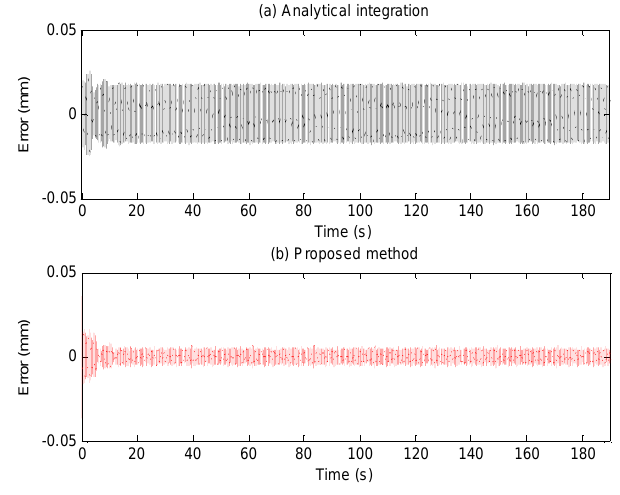
Figure 19. Estimation errors obtained from ( a ) analytical integration of the acceleration, ( b ) the proposed method ( i.e. , by numerically integrating the acceleration, then high-pass filtering, and compensating for the effects of both hardware filter and HPF